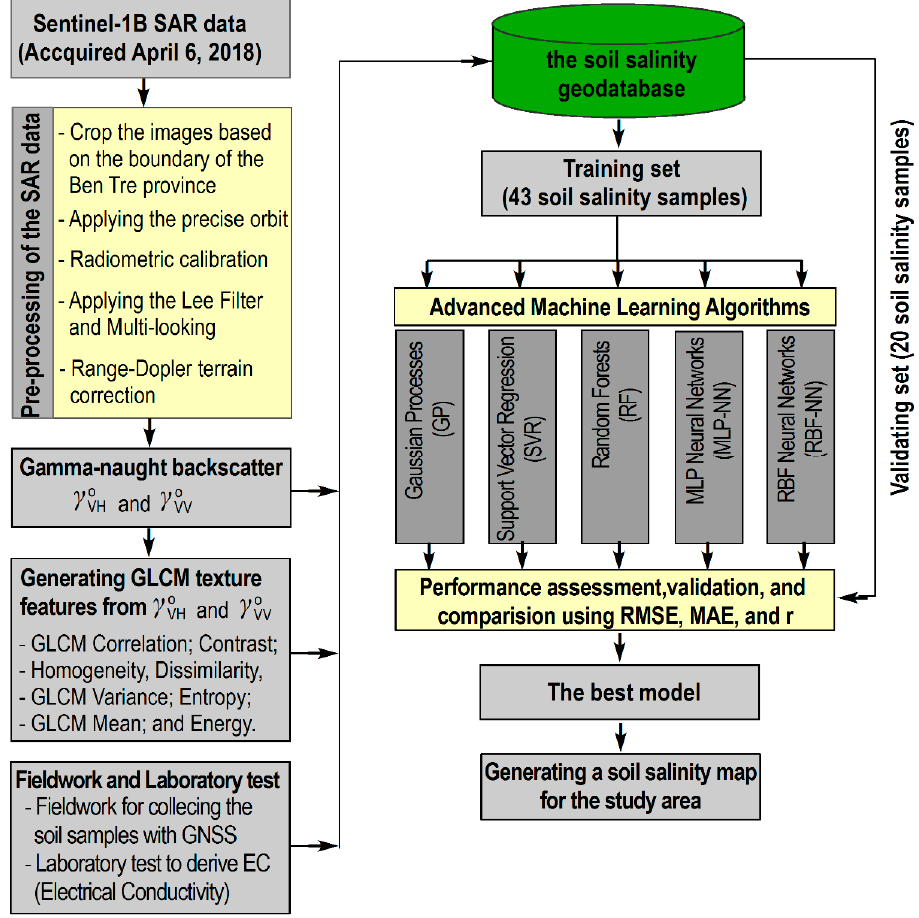
Figure 3. Proposed methodological flow chart for this research. GLCM: Grey Level Co-occurrence Matrix; RMSE: root-mean-square error; MAE: mean absolute error; SAR: Synthetic Aperture Radar; GNSS: Global Navigation Satellite System.